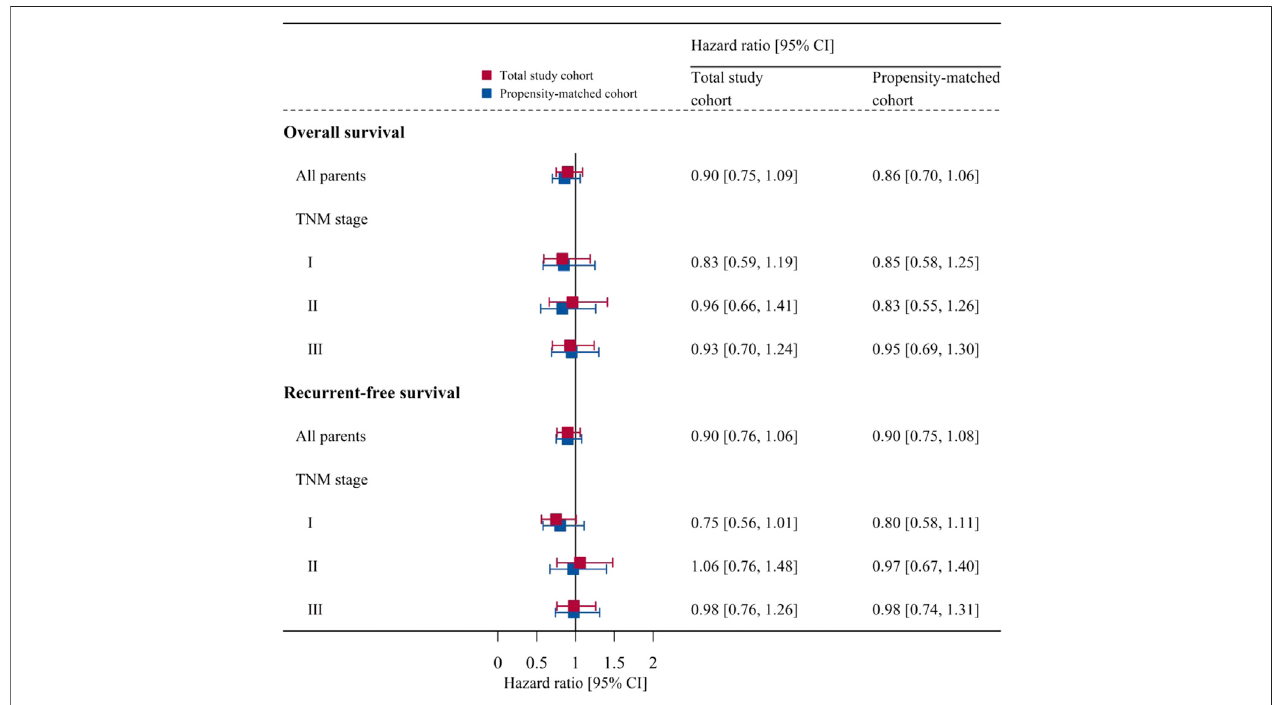
FIGURE 4 | Subgroup analyses for each TNM stage of NSCLC: association of anesthesia type with overall survival or recurrent-free survival before and after matching. Data are presented as hazard ratio [95% CI]. CI, con fi dence interval; TNM, tumor-node-metastasis.